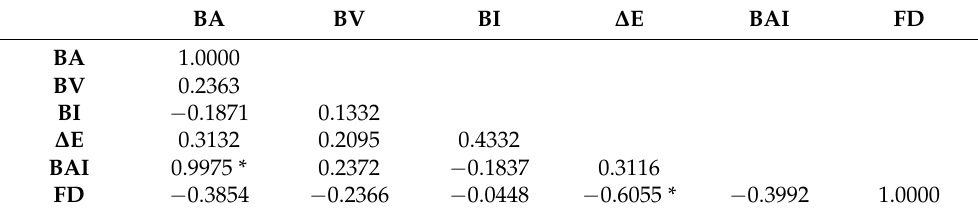
Table 6. Bruise assessment parameters of guava fruit stored at 25 ◦ C under 70% RH for four days. BA BV BI ∆ E BAI FD BA 1.0000 BV 0.2363 BI − 0.1871 0.1332 ∆ E 0.3132 0.2095 0.4332 BAI 0.9975 * 0.2372 − 0.1837 0.3116 FD −